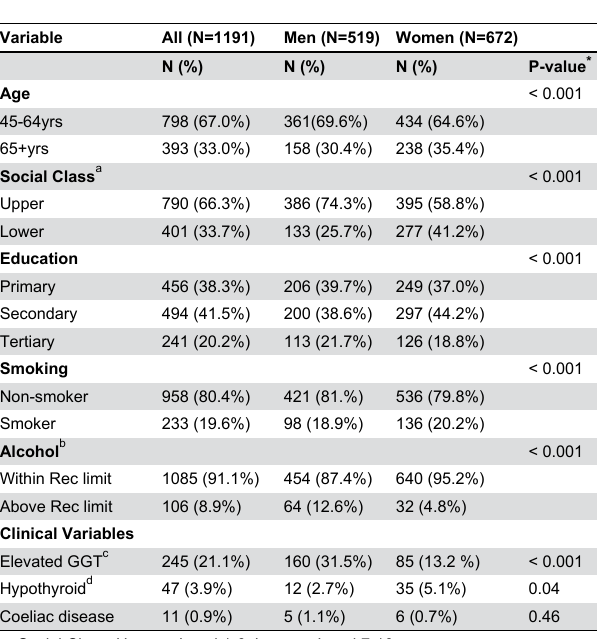
Table 1. Socio-Demographic Characteristics of the Study Sample and Relevant Clinical Variables by Gender.